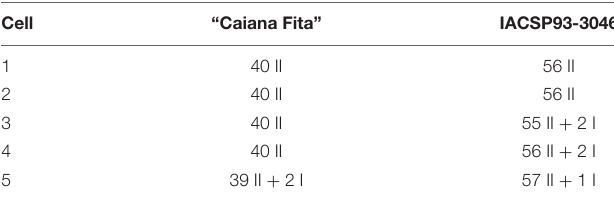
TABLE 2 | Chromosome associations observed at diakinesis of the “Caiana Fita” clone and IACSP93-3046 variety (I and II denote uni- and bivalents, respectively) Cell “Caiana Fita”